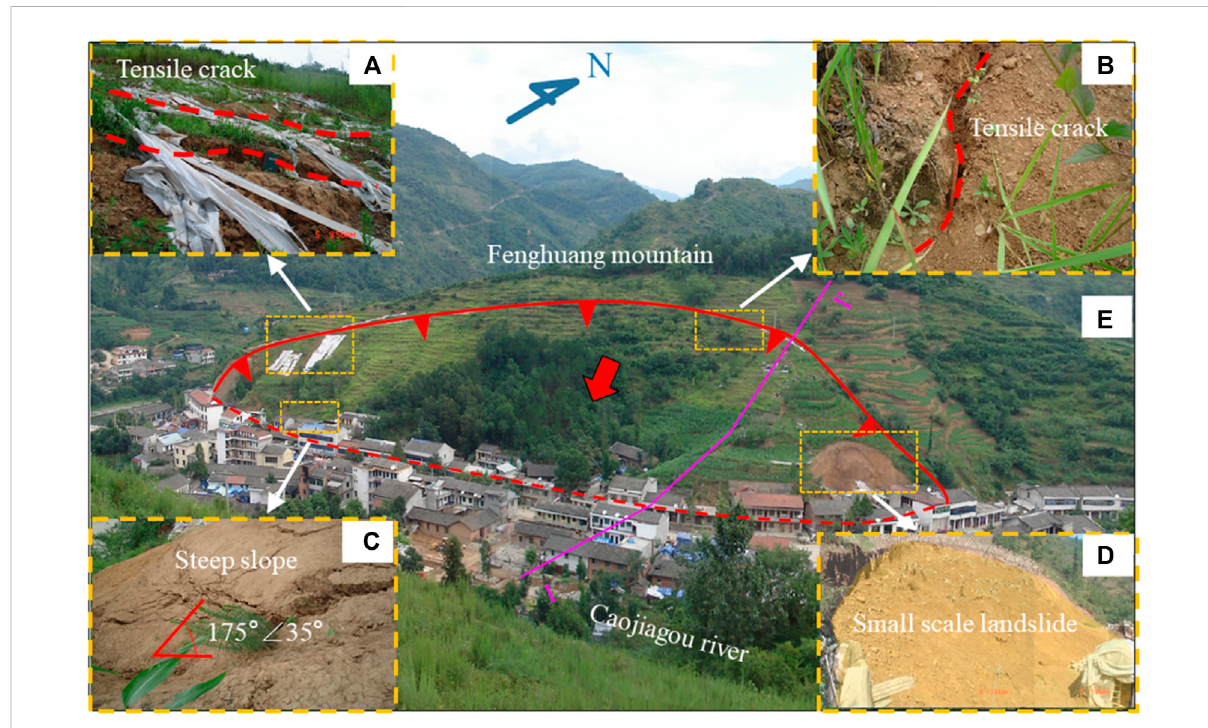
FIGURE 3 Geological pro fi le of section Ⅰ - Ⅰ ’ (the location of the cross section is shown in Figure